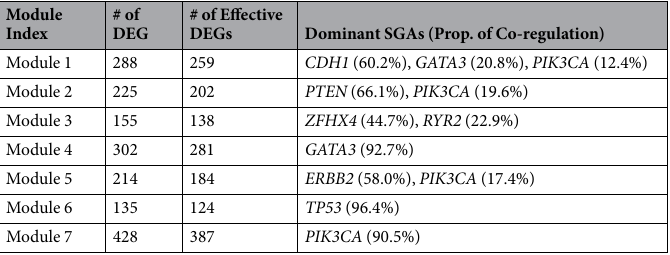
Table 1. The composition of DEG modules of BRCA, including the number of DEGs, the number of effective DEGs, the dominant SGAs, and the proportion of co-regulations produced by each dominant SGA.